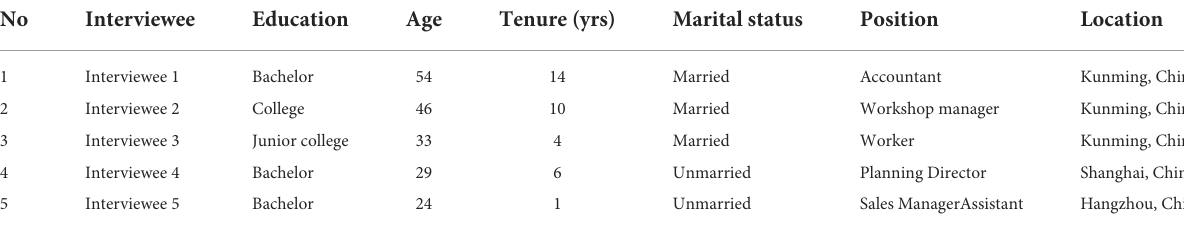
TABLE 1 Demographic information of